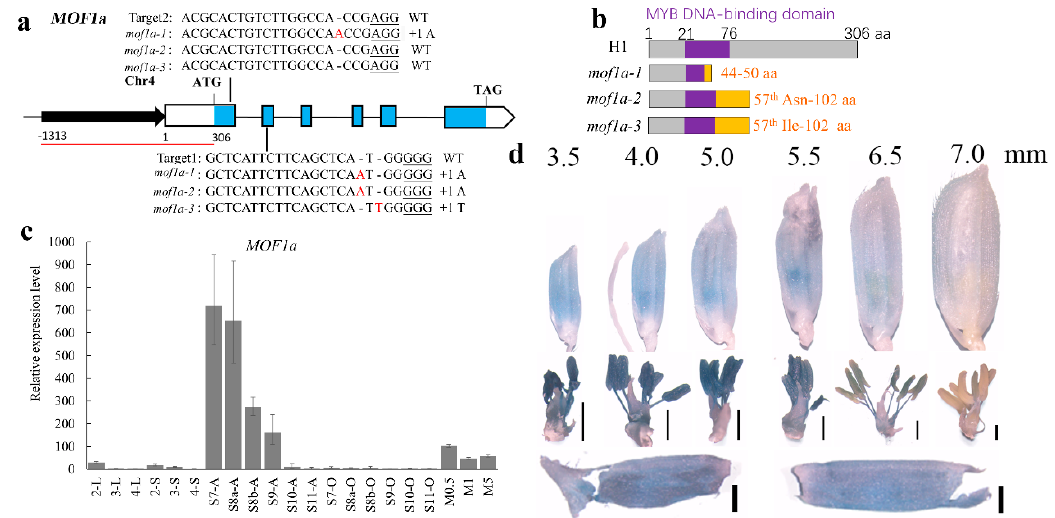
Figure 2. Gene information and expression pattern of MOF1a in H1. ( a ) A schematic diagram of the MOF1a gene bearing two CRISPR–Cas9 target sites indicated by black lines. UTRs, CDS regions, and introns are represented by white boxes, blue boxes, and lines, respectively. The two sides of the diagram show the alignment of wild-type (WT), mof1a-1 , mof1a-2, and mof1a-3 sequences containing the CRISPR–Cas9 target sites. The 20 bp CRISPR–Cas9 target sequences adjacent to the underlined protospacer adjacent motifs (PAMs) are indicated in the WT sequences. The newly created mof1a-1 , mof1a-2, and mof1a-3 mutants contain a 2 bp insertion of A, 1 bp insertion of A and 1 bp insertion of T (red), respectively. The region from -1313 to 306 bp covered by red line indicate the promoter of MOF1a from H1 for MOF1a promoter- β -glucuronidase (GUS) vector (pMOF1a::GUS). ( b ) Schematic diagrams of MOF1a proteins in H1 and mof1a . aa, amino acids. The orange panels (right) indicate predicted mutant protein fragment of mof1a-1 , mof1a-2, and mof1a-3 according to their new genotypes. The MOF1a proteins in mof1a-1 , mof1a-2, and mof1a-3 only keep 43 aa, 56 aa, and 56 aa as same as the MOF1a protein sequence of wild type plants. ( c ) Quantitative real-time PCR analysis of MOF1a expression in various tissues of H1 plant. Results are normalized against the expression levels of ubiquitin and shown as relative values to the lowest level set to 1. means (bars) and standard error (error bars) of three independent biological replicates are shown. 2, S8a; 3, S11; 4, 5 days after flowering; L, leaf; S, sheath; A, anthers; O, ovaries; S7 to S11, stages of anther development; M0.5, panicle with 0.50 cm length; M1, panicle with 1.00 cm length; M5, panicle with 5.00 cm length. ( d ) GUS staining of pMOF1a::GUS lines shows that MOF1a highly expresses in stamen, palea, and lemma. The numbers on the top side indicate the length of observed spikelets. 2.3. The Mutants with Low Pollen Fertility Were Obtained by CRISPR / Cas9 in Neo-Tetraploid